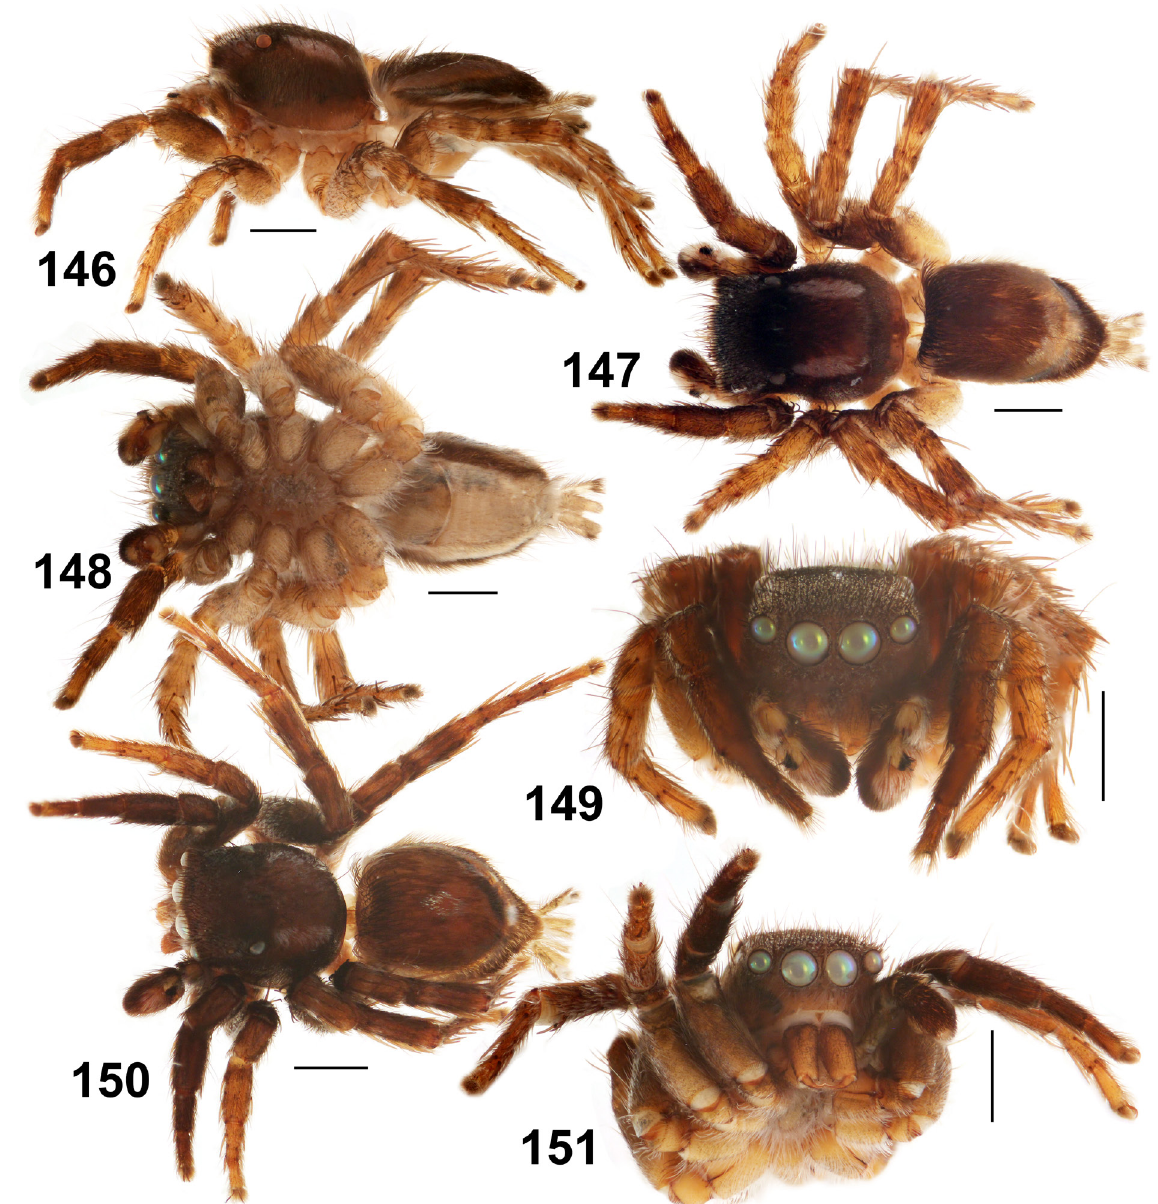
Figs 146–151. Stenaelurillus fuscatus Wesołowska & Russell-Smith, 2000, holotype, ♂ (150–151) and ♂ from Kenya (Taita Discovery Centre; MRAC 213.133) (146–149), general appearance. Scale bars: 1